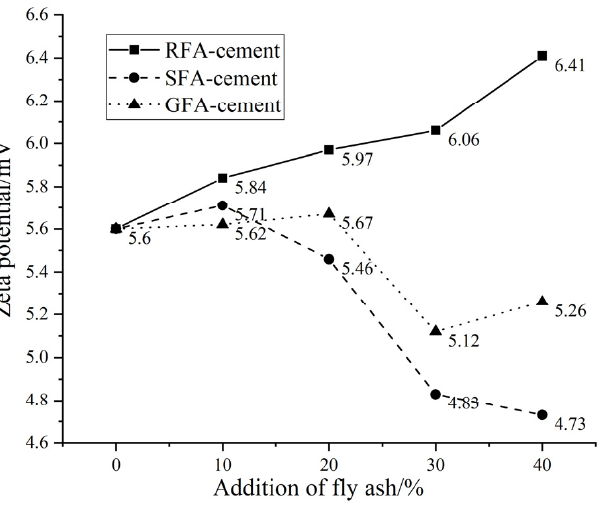
Figure 9. Zeta potential of cement paste containing different fly ash.